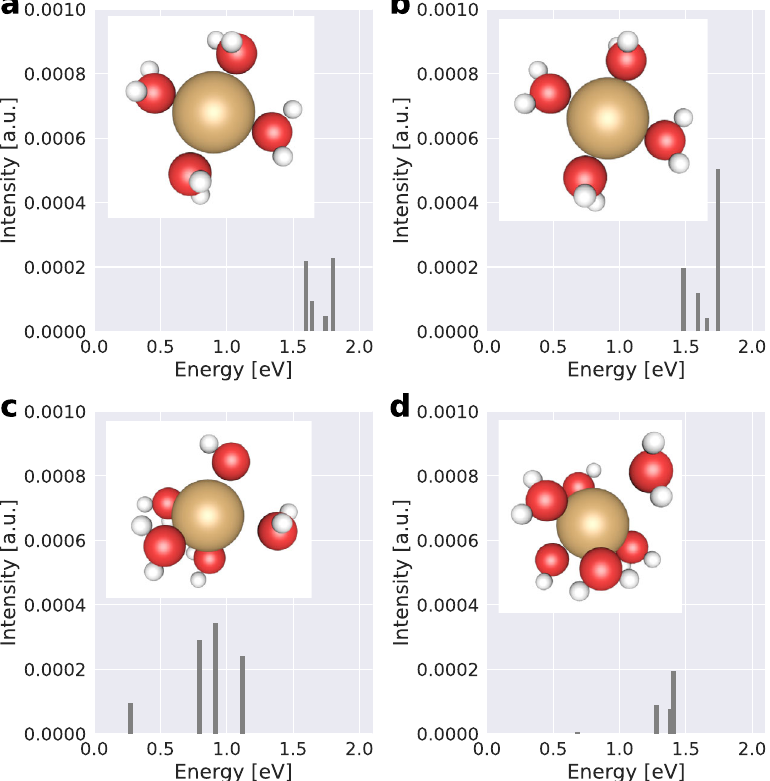
Fig. 2 Structures of the Cu(II) aqua complex from AIMD ( fi gure insets) and their corresponding simulated optical transitions. The central copper ion is surrounded by either ( a , b ) four, ( c ) fi ve, or ( d ) six water molecules, with fi vefold coordination being the most common. Slight structural perturbations ( a , b ) and changes in coordination ( c , d ) result in noticeably different shifts of the energies and intensities. The discrete spectral peaks were computed from time-dependent density functional theory (TDDFT)